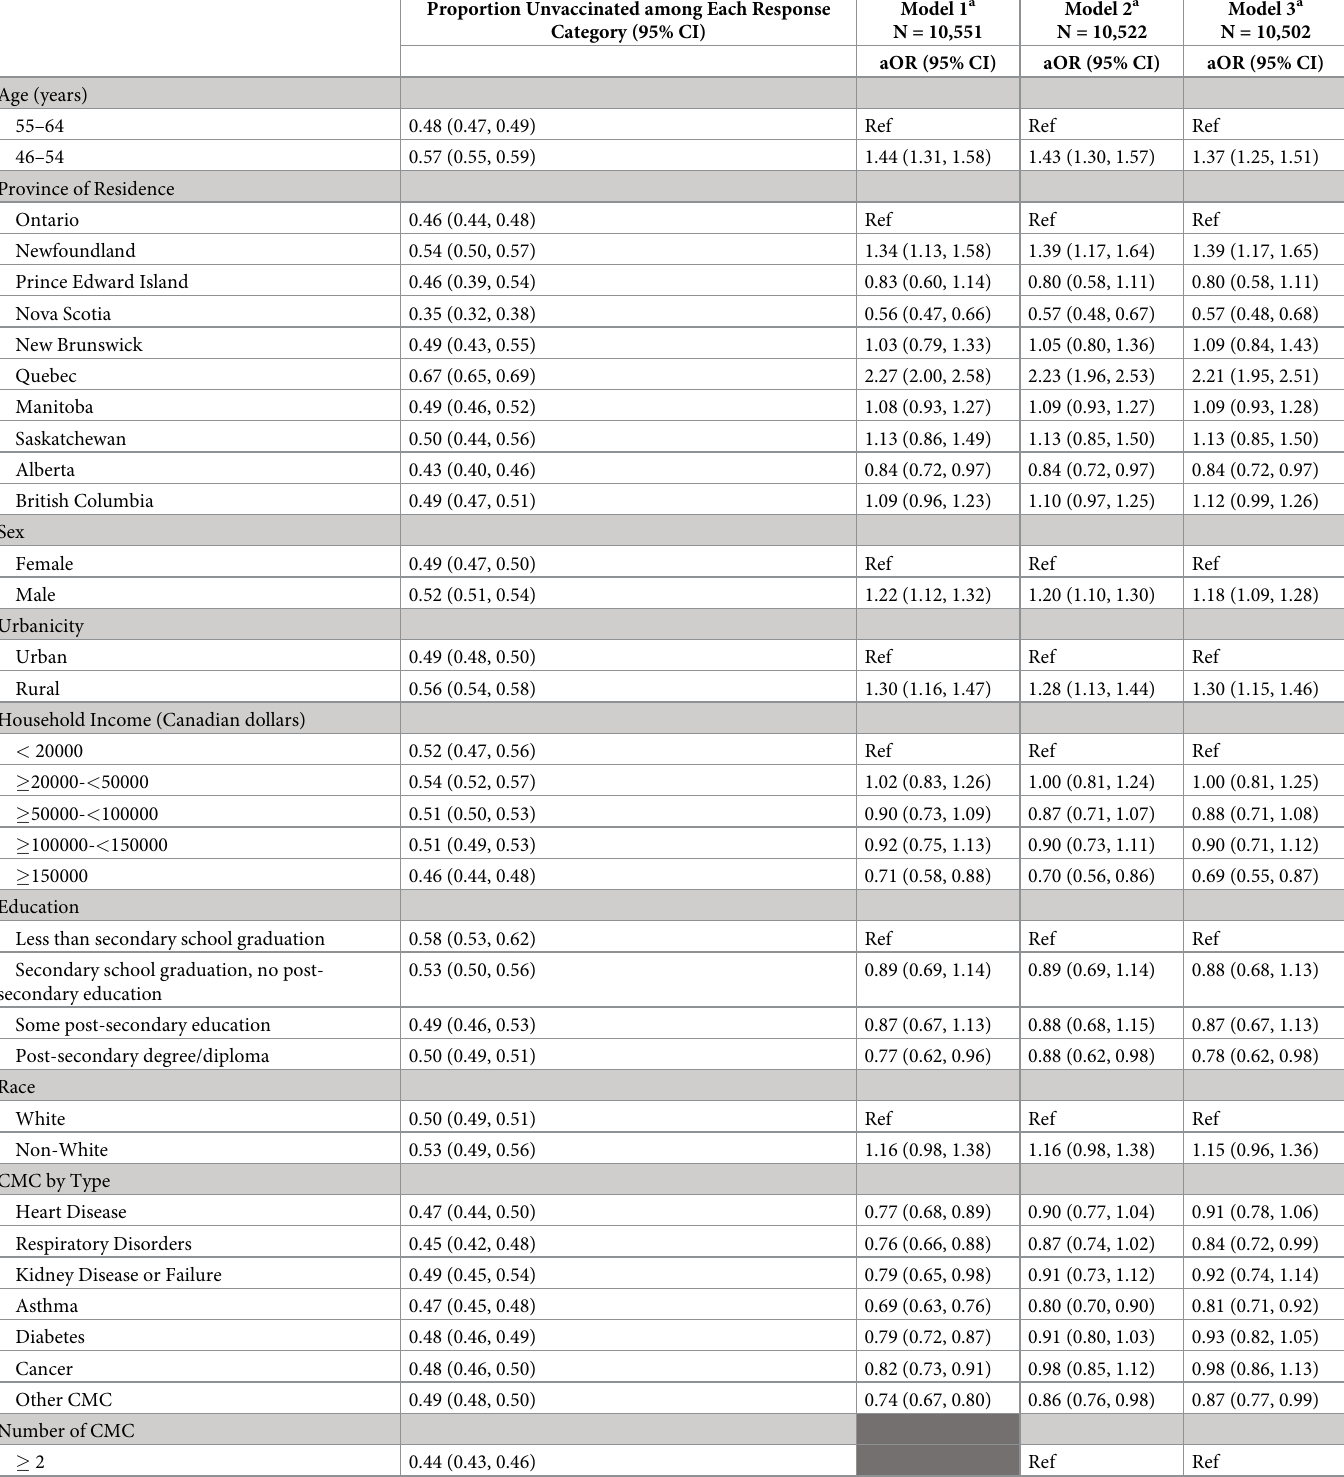
Table 4. Factors associated with seasonal influenza non-vaccination among Canadian residents aged 46–64 years with at least one chronic medical condition (CMC) (N =